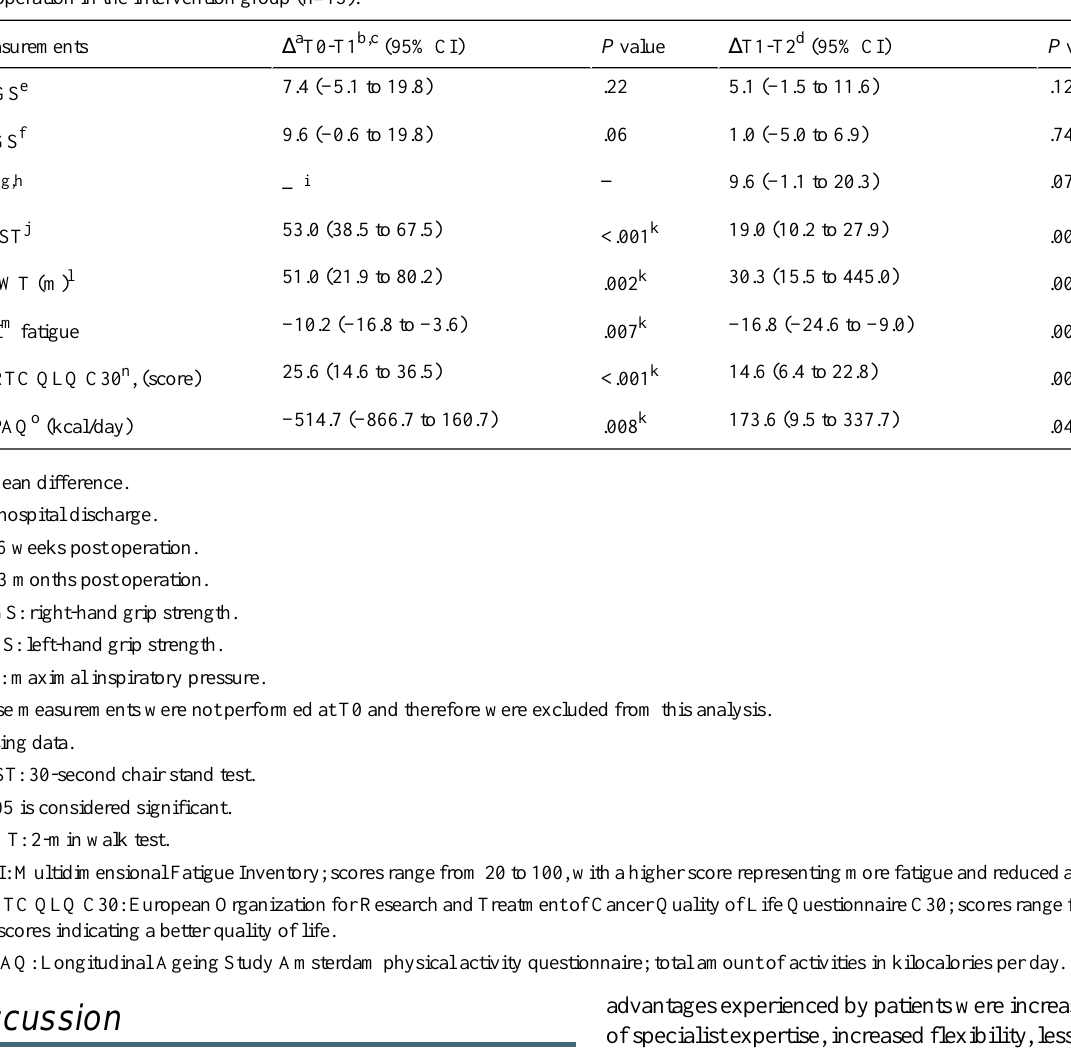
Table 5. Mean differences in functional status outcomes between hospital discharge and 6 weeks post operation (T1) and between T1 and 3 months post operation in the intervention group